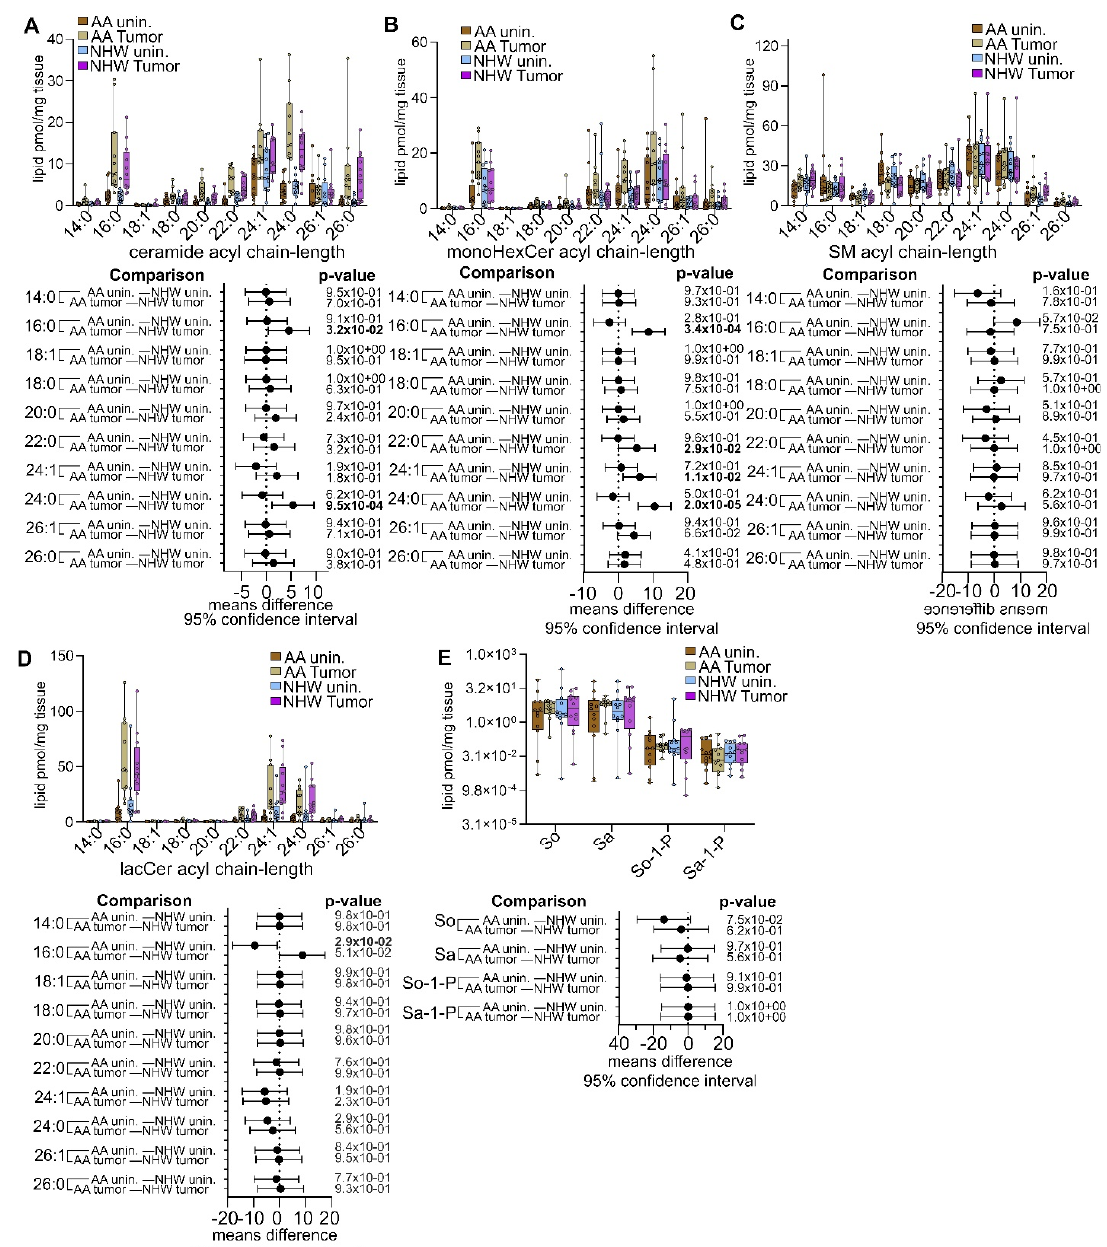
plots of the 95% family-wise significance and confidence intervals for predicted means difference (means diff.) calculated following ANOVA. Corresponding unadjusted p -values (Fisher’s LSD; Prism) for the indicated comparisons are shown to the right of the 95% confidence interval plots. The lower limit of p - and q-value calculations was set to 1.0 × 10 − 15 (Prism), so no values are reported lower than this limit. For p -adjusted (q) values corrected for multiple comparisons using the FDR (Q = 0.05) and the two-step controlling procedure of BKY, see Supplementary Table S19. For panel ( E ), the y -axis is in log2 scale. Alterations considered significant ( α ≤ 0.05) are in bold text.